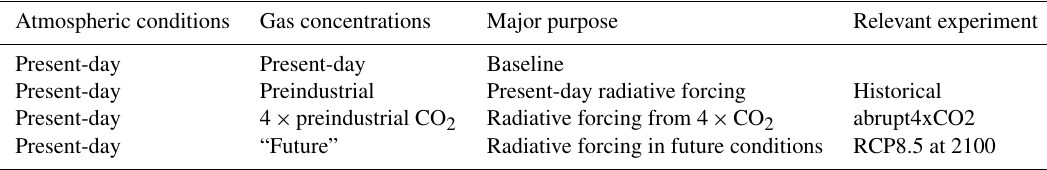
Table 3. Sets of atmospheric conditions to be supplied by RFMIP for assessing parameterization error in clear-sky top-of-atmosphere flux changes. The entire set of conditions is described as CMIP experiment RFMIP-IRF with CMIP6 label (experiment_id) rad-irf.